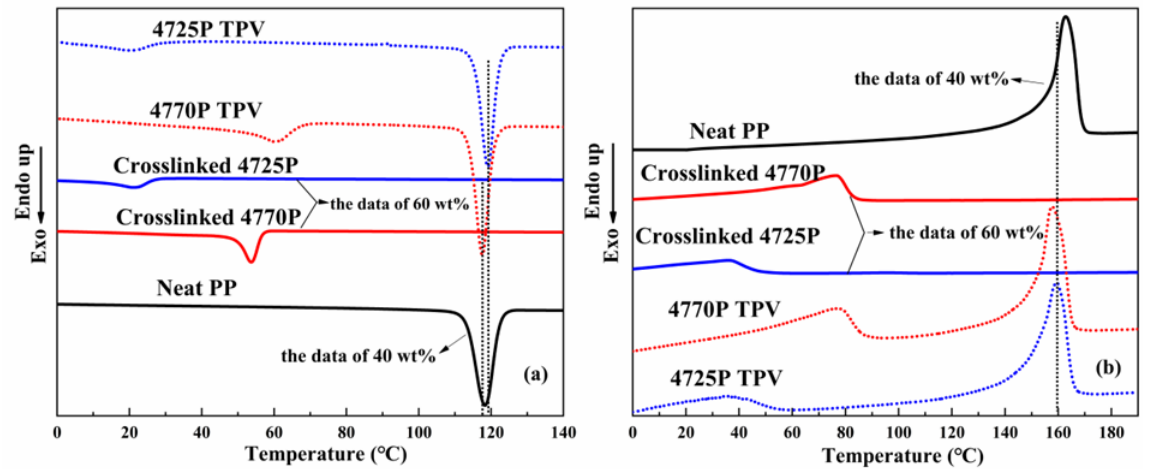
Figure 4. DSC cooling (10 °C/min) thermograms and the subsequent melting (10 °C/min) thermograms of neat PP, crosslinked EPDMs, and TPVs: ( a ) cooling thermograms; ( b ) the subsequent melting thermograms.